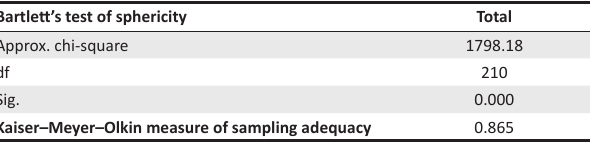
TABLE 3: Kaiser–Meyer–Olkin and Bartlett’s test. Bartlett’s test of